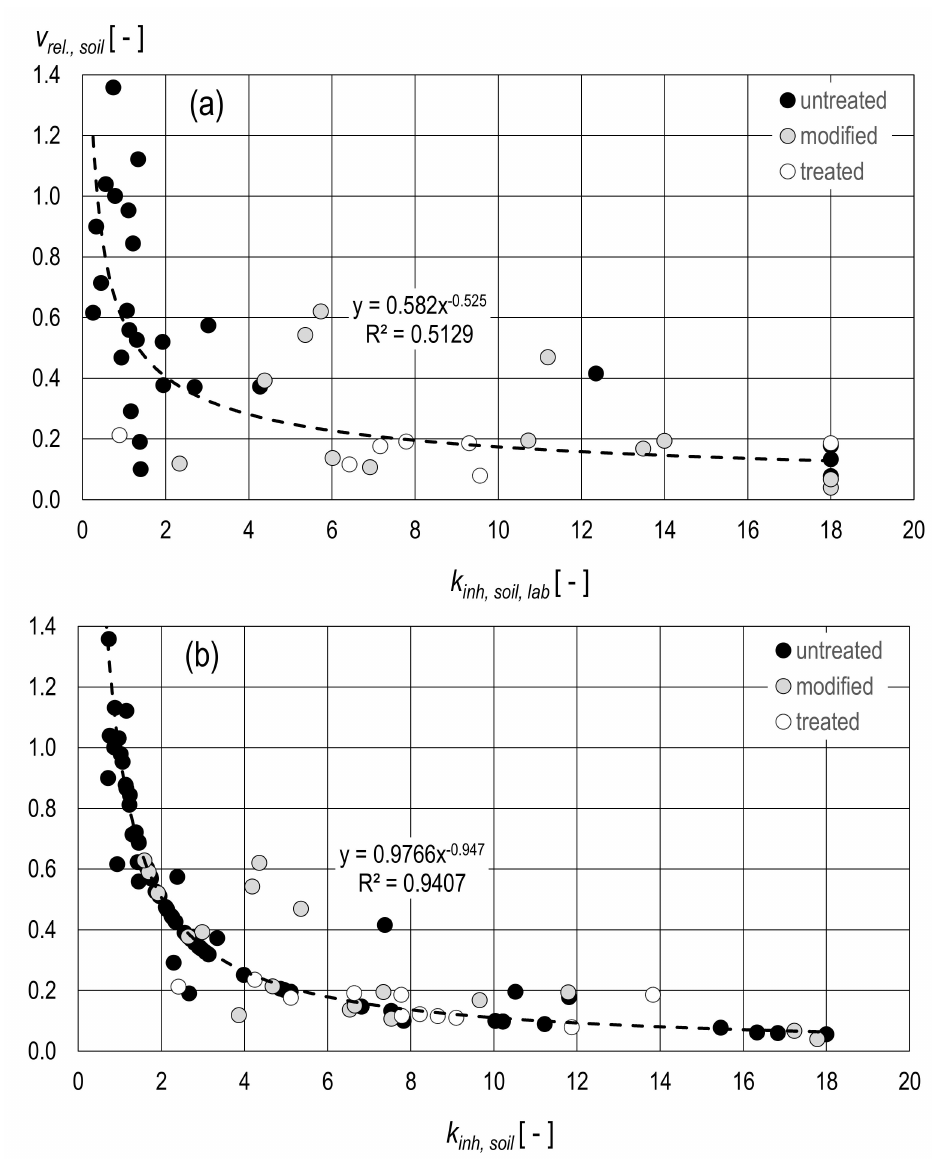
Figure 3. Relationship between relative decay rate in soil contact ( v rel.,soil ) and factors accounting for inherent protective properties in soil contact. ( a ) Excluding field test data ( k inh,soil,lab ), and ( b ) including field test data ( k inh,soil ). The basis was ( a ) 27 untreated, 12 modified and 7 preservative-treated timbers, and ( b ) 168 untreated, 18 modified and 11 preservative treated-timbers,